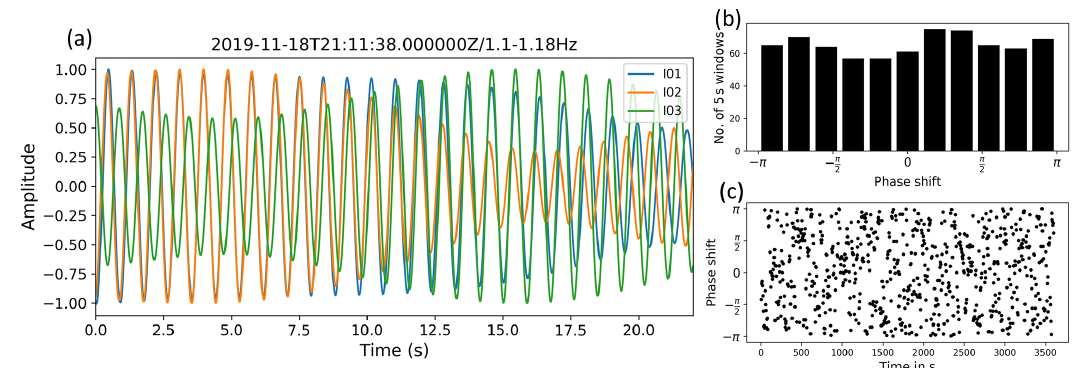
Figure 6. (a) Comparison of seismograms (vertical components) measured simultaneously in each of the three WTs at a rotation rate of 11– 12rpm. Waveforms are filtered to 1.10–1.18Hz, and amplitudes are normalized to their maximum. (b) Distribution of phase shift between signals in 5s time segments measured in two WTs (I01 and I02) during a period of 1h with WT rotation rates of 11–12rpm. (c) Temporal development of the phase shift between the signals measured in the two WTs (I01 and I02).